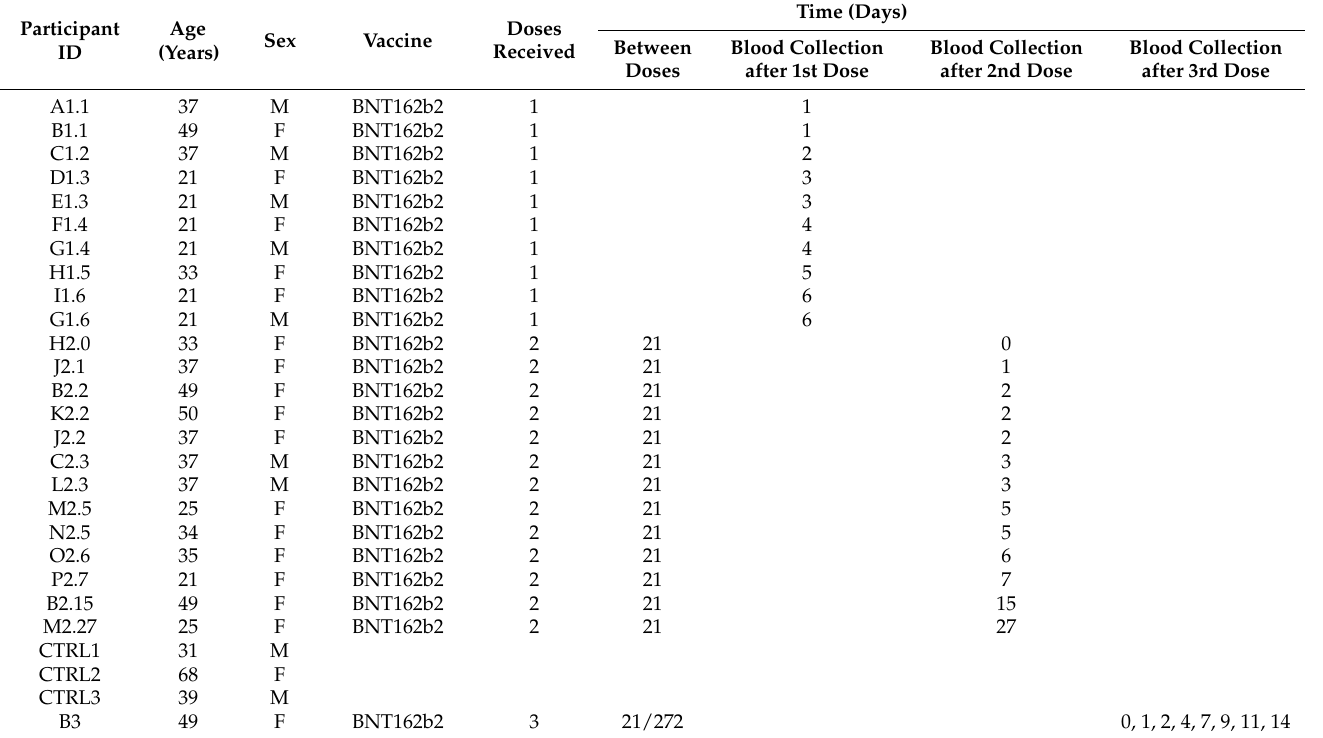
Table 1. Characteristics of enrolled subjects. Each letter of the participant ID designates an individual, while numbers represent dose and day of sampling,